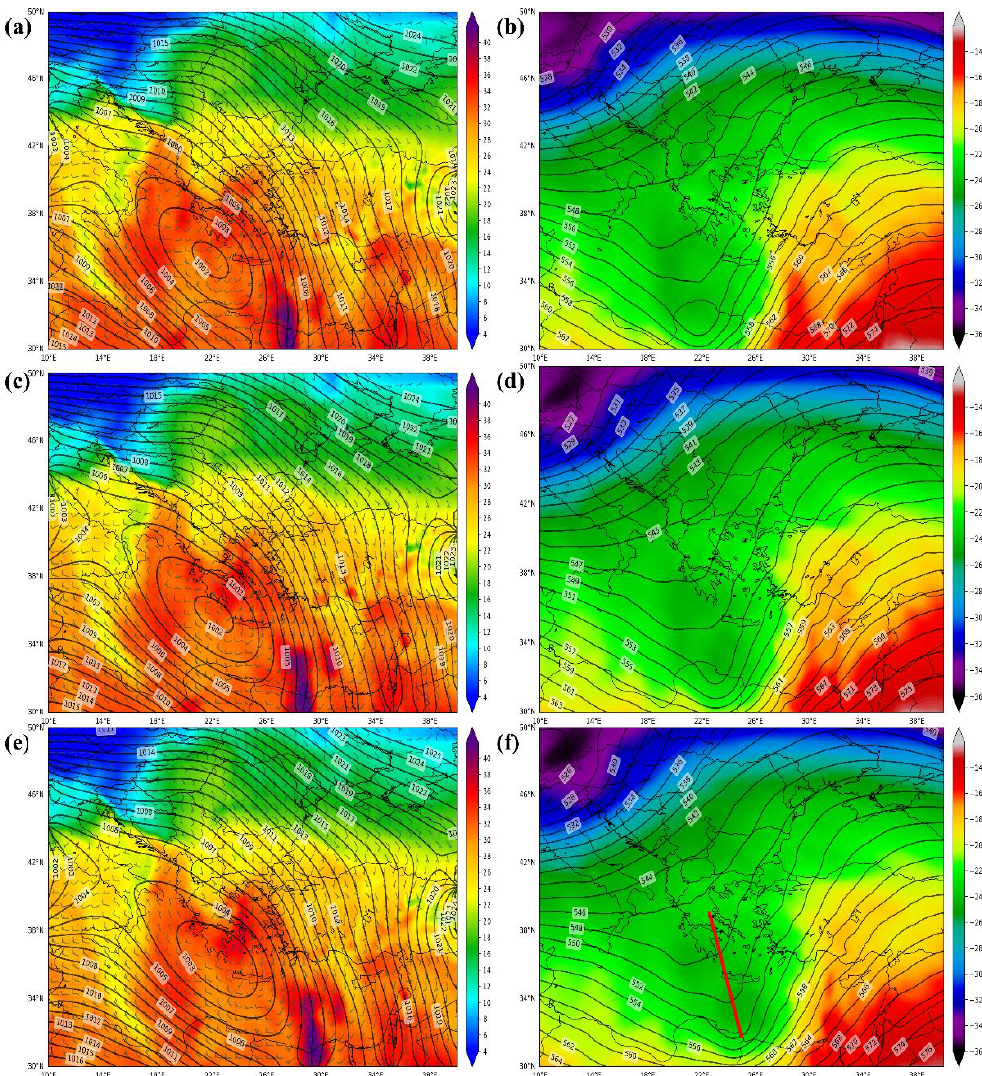
Figure 12. As in Figure 2 but for 22 February 2013, 0200 UTC ( a , b ), 0400 UTC ( c , d ) and 0600 UTC ( e , f ). The red line in map ( f ) indicates the negatively tilted trough axis.